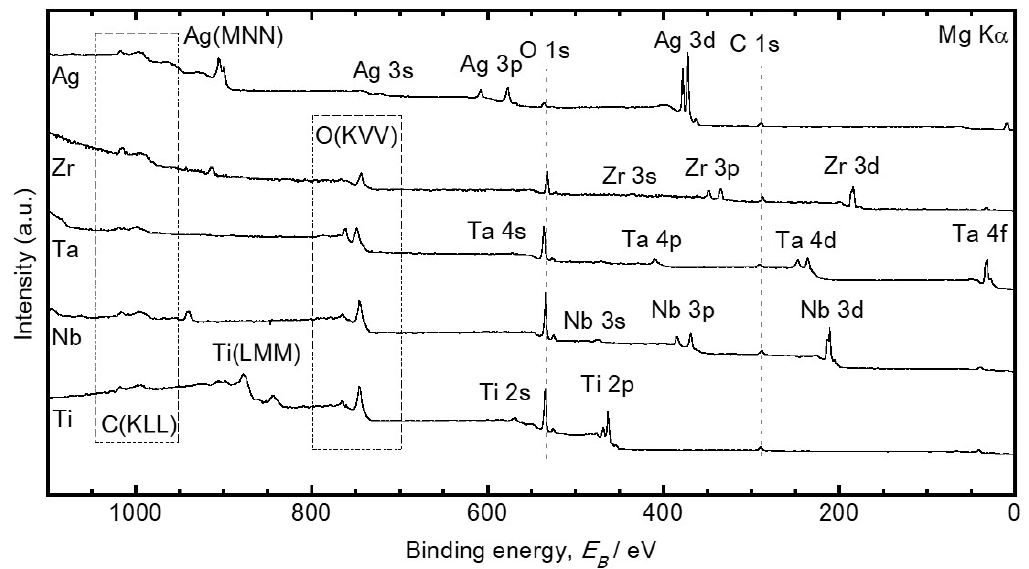
Figure 1. X-ray photoelectron spectroscopy survey (XPS) spectra obtained from the Ti, Nb, Ta, Zr, and Ag specimens. The spectra obtained from Ti, Nb, Ta, Zr, and Ag are arranged from the bottom, respectively.